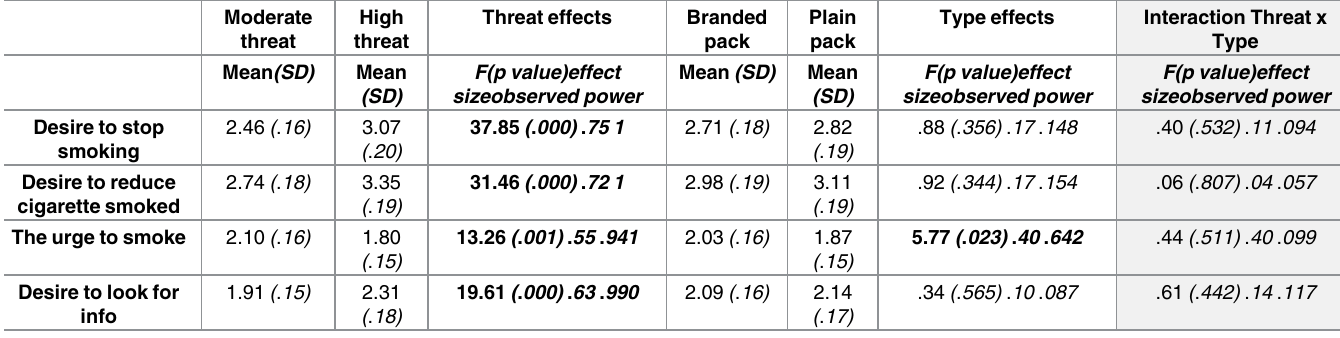
Table 2. Effects of threat level and pack type on behavioral